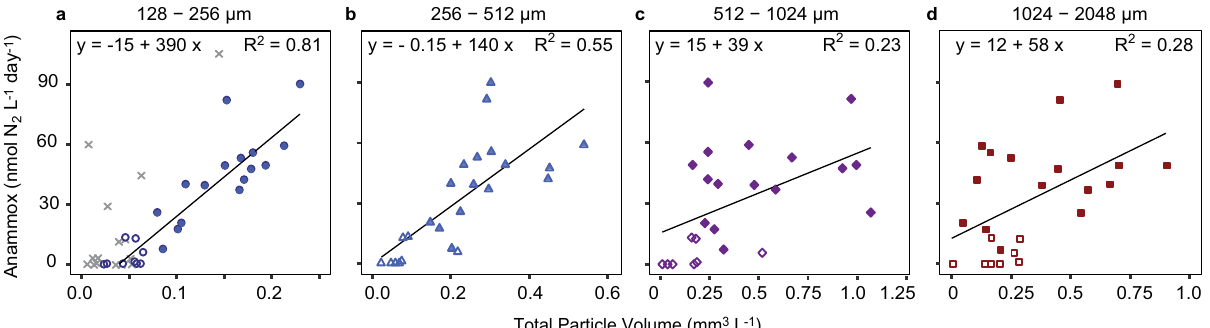
Fig. 4 Relationship between volumetric anammox rates and particle volumes from different size classes in the Peruvian upwelling system during April 2017. Particles throughout the water column were quanti fi ed with an Underwater Vision Pro fi ler camera system (UVP) and binned into four size classes with equivalent spherical diameters (ESD) of 128 – 256, 256 – 512, 512 – 1024, and 1024 – 2048 µ m. Anammox rates were determined from the slope of 29 N 2 production over time in anoxic incubations after addition of 15 NO 2 − (taking into consideration any contribution to 29 N 2 production from denitri fi cation if a denitri fi cation rate with p < 0.05 could be detected). For all particle size classes, there was a signi fi cant positive correlation (Spearman ’ s rank correlation; p = <0.05) between particle volume and anammox rates from the anoxic part of the oxygen minimum zone (O µ M). The line is the linear regression 2 < 1.5 from which the slope and R 2 was calculated (see Supplementary Table 5 for all relevant statistics). Please note the different scales for the particle volume a – d . One outlier was removed from the fi gures and correlation as it was more than 6 standard deviations from the mean in the smallest size fraction and it was the only sample from the euphotic zone (24.3 m depth). In a – d , open and fi lled symbols depict offshore stations and onshore stations, respectively. In panel a , the correlation with the smallest size class (140 – 270 µ m) during a cruise in February 2013 (M93) is included for comparison and depicted with grey x symbols. This dataset was not included in the linear regression but is included in Supplementary Table 1c. Correlations with the particle abundance in number per liter yielded similar results (see Supplementary Table